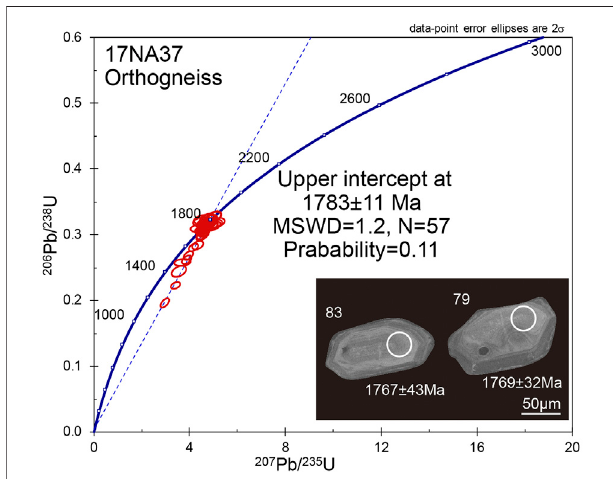
FIGURE 5 | Wetherill concordia diagram of orthogneiss sample 17NA37. The cathodoluminescent image of the representative zircons shows analyzed spots located in the core. The upper intercept age represents the assumed protolith crystallization age.